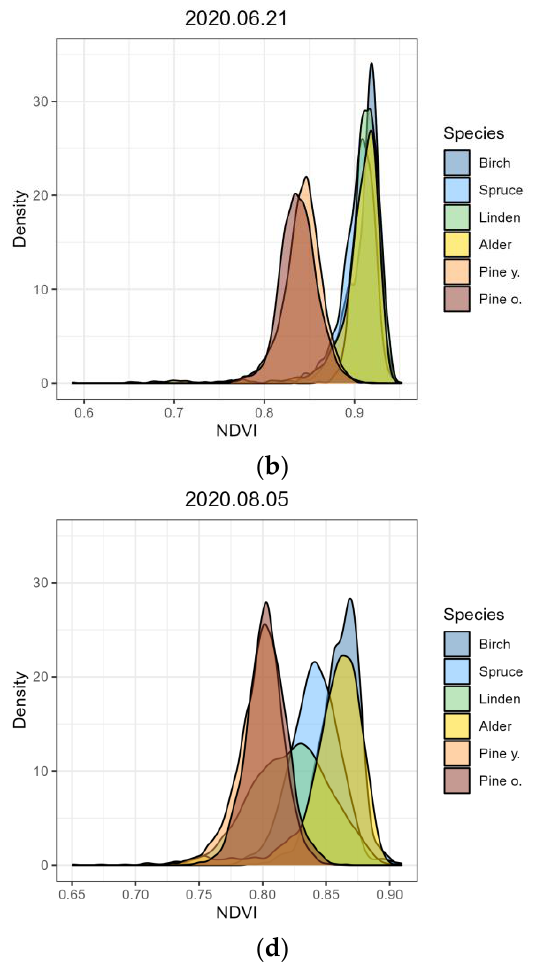
( f ) Figure 5. Histograms of the frequencies of NDVI values for different phenological dates: ( a ) 9 May 2020; ( b ) 21 June 2020; ( c ) 8 July 2020; ( d ) 5 August 2020; ( e ) 24 September 2020; ( f ) 29 October 2020. The analysis results of the tree species ’ spectral reflective properties, the weights of each of the 66 features included in the satellite composite (for 10 spectral bands and NDVI of 6 multi-temporal images) were set expertly — as shown Table 4. These weights were taken into account at the classification stage.